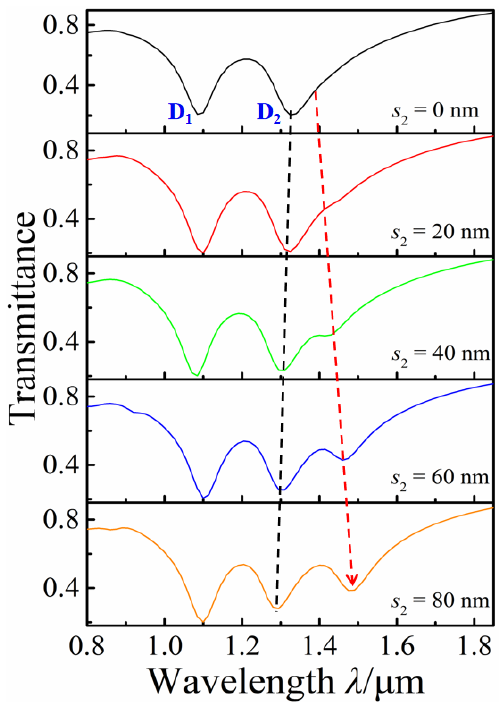
Figure 7. Transmission spectra of s 2 increasing from 0 nm to 80 nm.